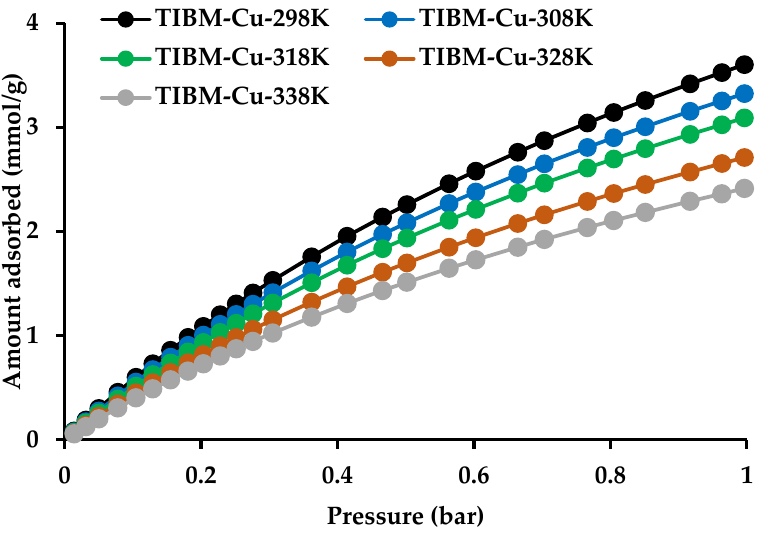
Figure 8. CO 2 adsorption capacity of TIBM-Cu MOF at increasing temperatures.